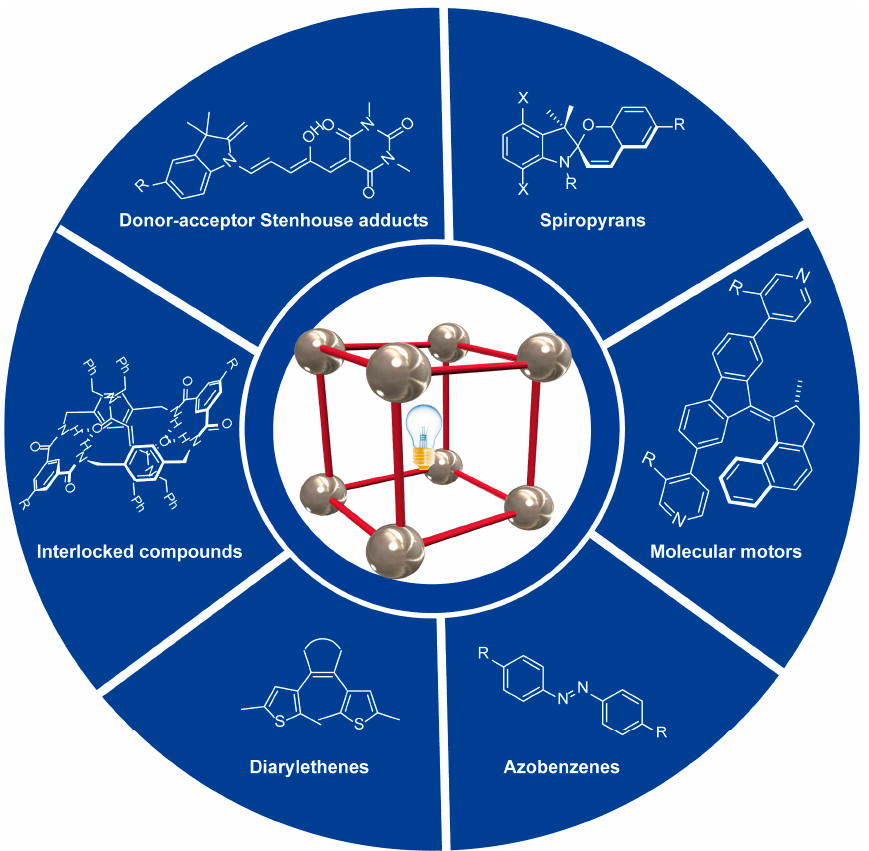
Figure 1. Selected photoactive organic ligands employed to prepare light-responsive metal-organic frameworks.